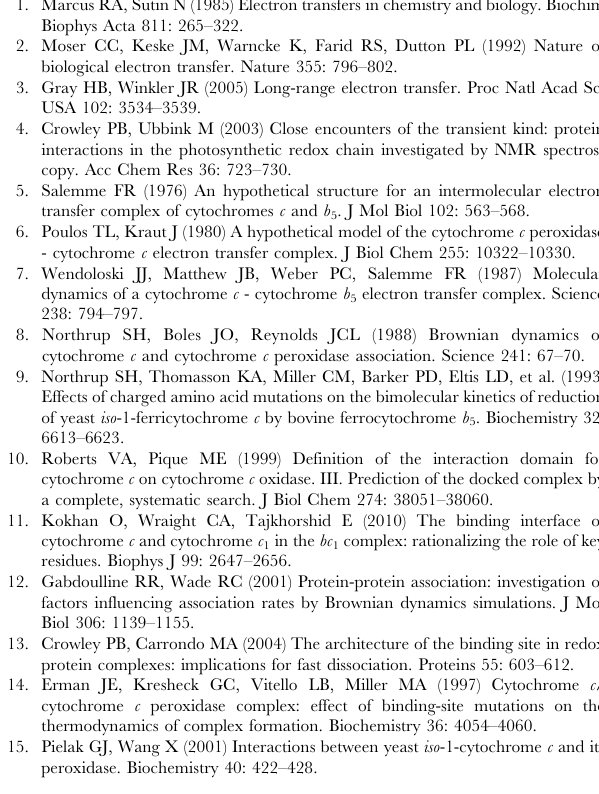
the heme-heme distances and the corresponding ET rates. For details, see the legend to Figure 3 in the main text. Video S3 Distribution of Cc CMs around CcP in ternary complexes colored by the heme-W191 distances and the corresponding ET rates. See the legend to Figure S1 for details.